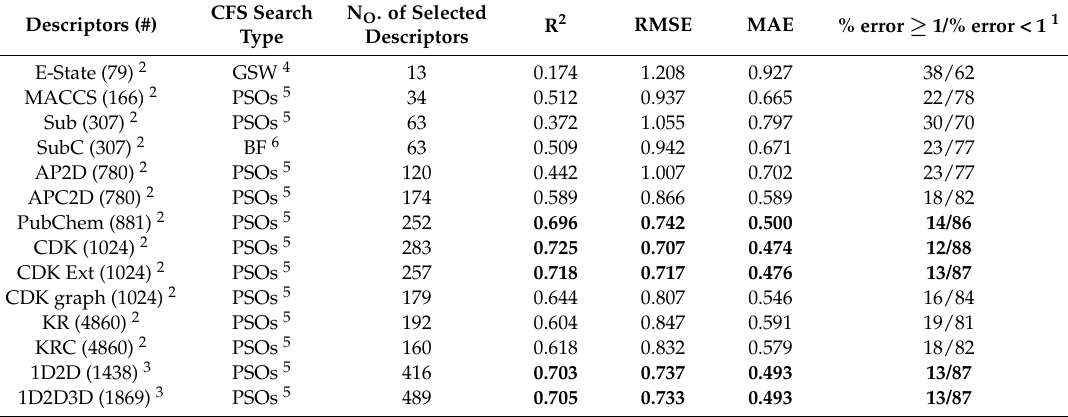
Table 3. Exploration of two collections of empirical descriptors for the quantitative structure-activity relationship k -nearest neighbors (QSAR k -NN) model of pIC 50 for the training set with a ten-fold cross-validation. The best models are highlighted in